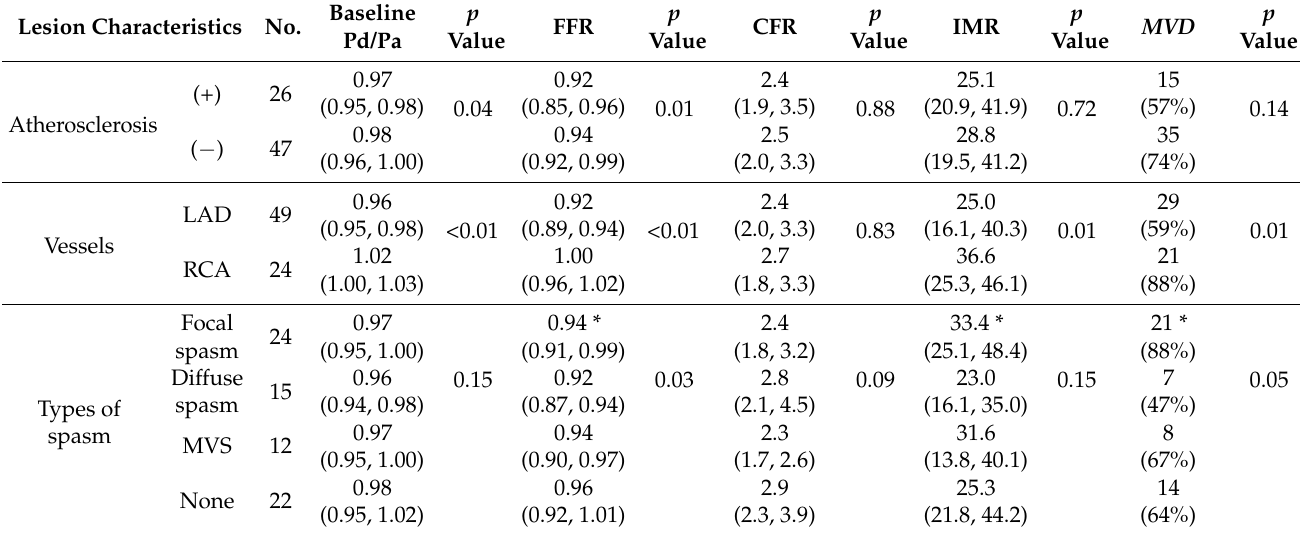
Table 2. Relationship between MVFT and lesion characteristics.